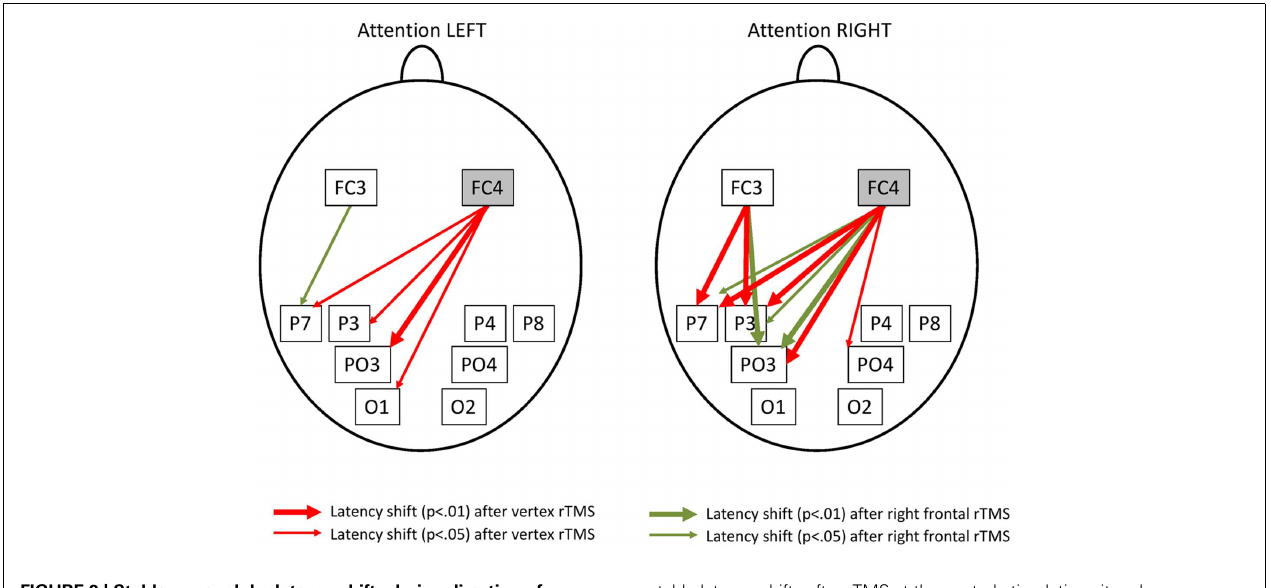
FIGURE 3 | Stable upper alpha latency shifts during directing of visuospatial attention. Arrows indicate consistent upper alpha latency shifts between recording sites. Note that prefrontal sites are always leading posterior sites during shifts of visuospatial attention. Red arrows indicate